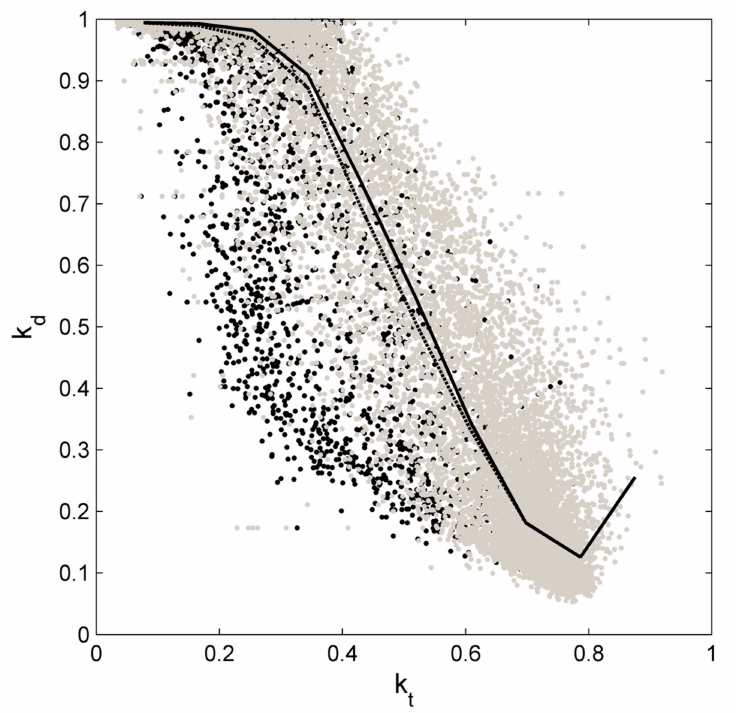
Figure 2. Scatterplot of k t vs k d for Bolzano station (2011–2014 data). Grey dots represent observations not affected by orographic shadows, while black dots correspond to the hours partially or totally affected by orographic shadows. The median values of k d , calculated for 10 equal-size k t intervals, are shown by the two black lines. The dotted line includes all observations, while the solid line corresponds only to the observations not affected by orographic